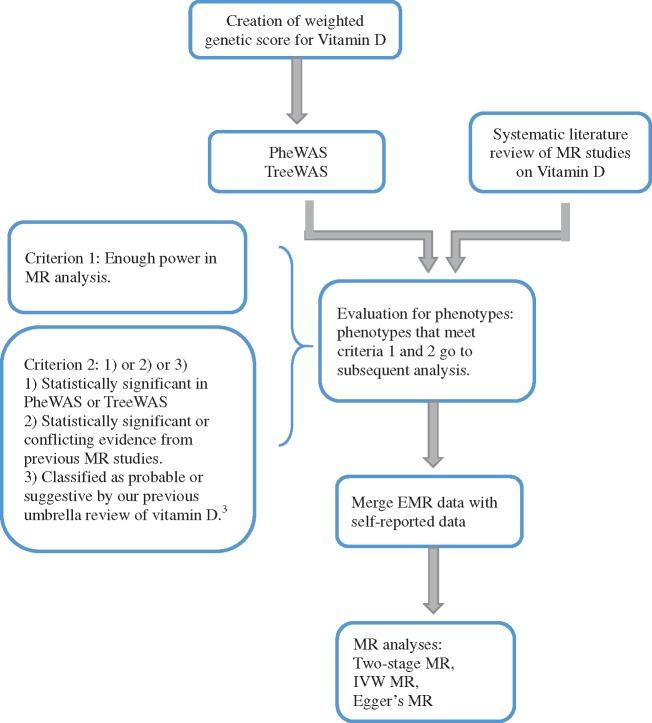
Study flowchart.